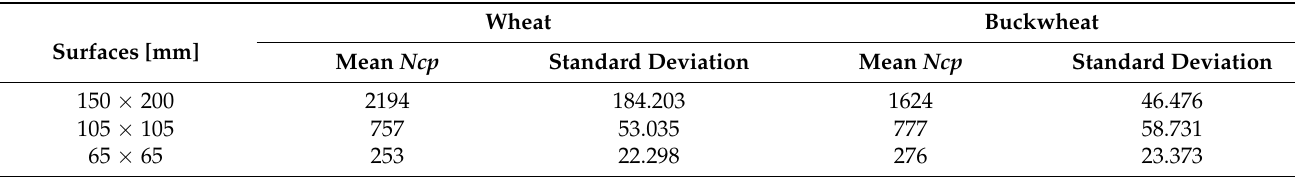
Table 1. Number of contact points ( N cp ) for wheat and buckwheat on three surfaces.